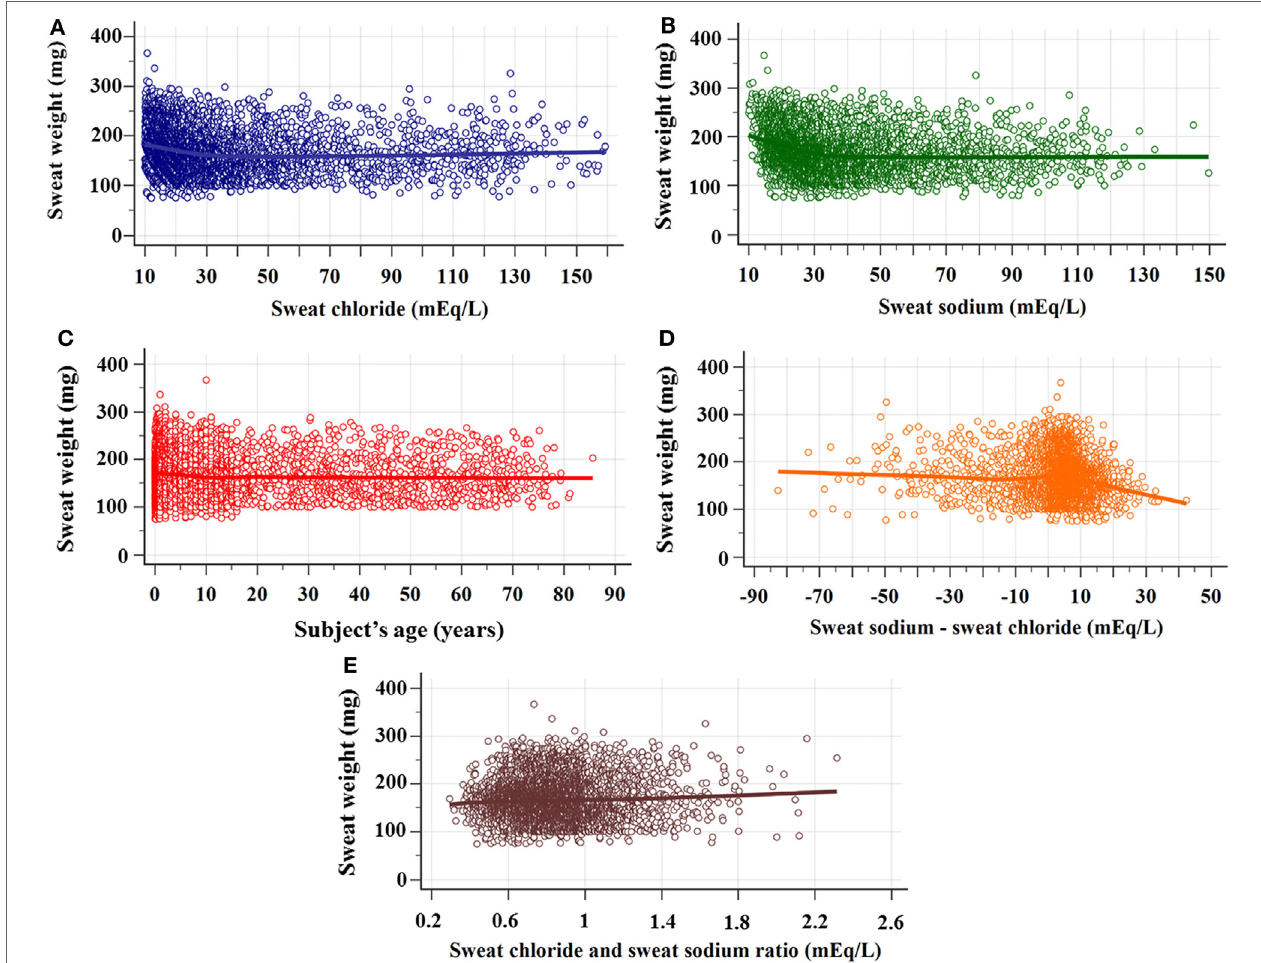
FigUre 2 | Correlation between sweat weight and sweat chloride and sodium concentrations, subject’s age, difference between sweat chloride and sodium concentrations, and sodium/chloride ratio. (a) Correlation between sweat weight and chloride concentrations. N = 5,277; rho = − 0.201 (95% CI = − 0.227 to − 0.175), p < 0.0001. (b) Correlation between sweat weight and sweat sodium concentrations. N = 5,277; rho = − 0.257 (95% CI = − 0.282 to − 0.232), p < 0.001. (c) Correlation between sweat weight and subject’s age. N = 5,136; rho = –0.075 (95% CI = –0.102 to –0.048), p < 0.0001. (D) Correlation between sweat weight and the difference between sweat sodium and chloride concentrations. N = 5,277; rho = –0.094 (95% CI = –0.121 to 0.067), p < 0.0001. (e) Correlation between sweat weight and chloride/sodium ratio. N = 5,277; rho = 0.007 (95% CI = –0.02 to 0.034), p = 0.621. The statistical analysis was performed by Spearman’s rank correlation test. α = 0.05. 95% CI, confidence interval of